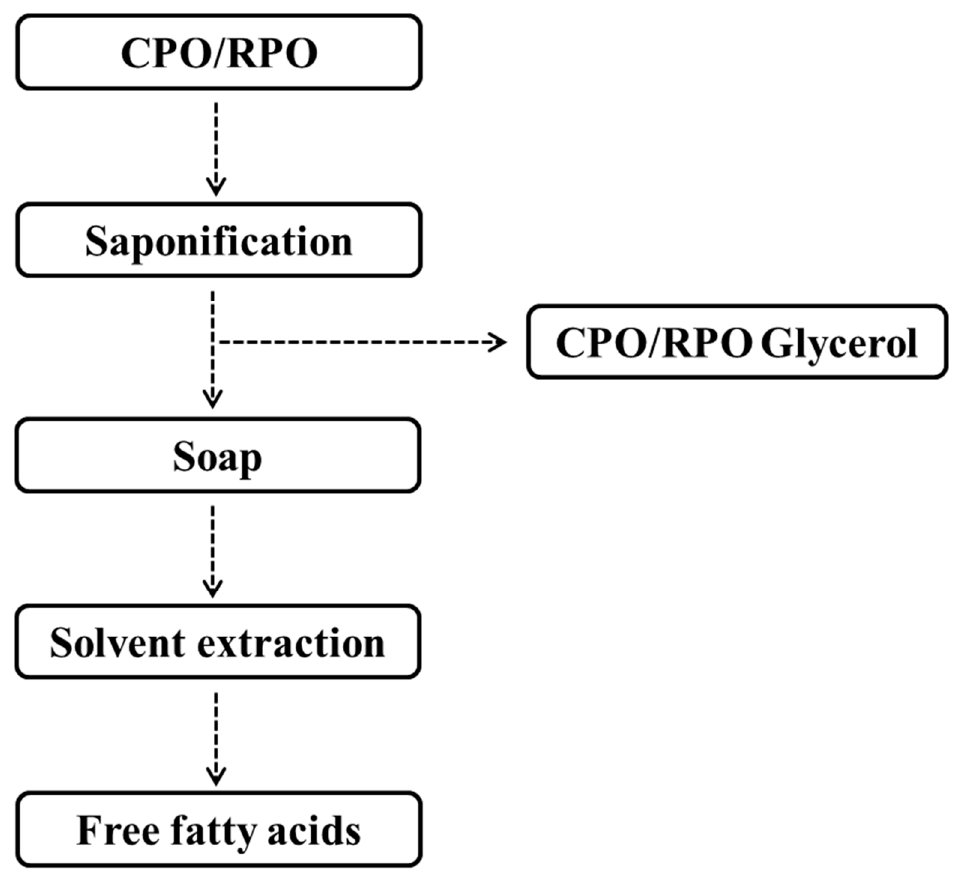
Figure 6. Flow diagram of free fatty acids (FFAs) extracted from crude palm oil (CPO) and refined palm oil